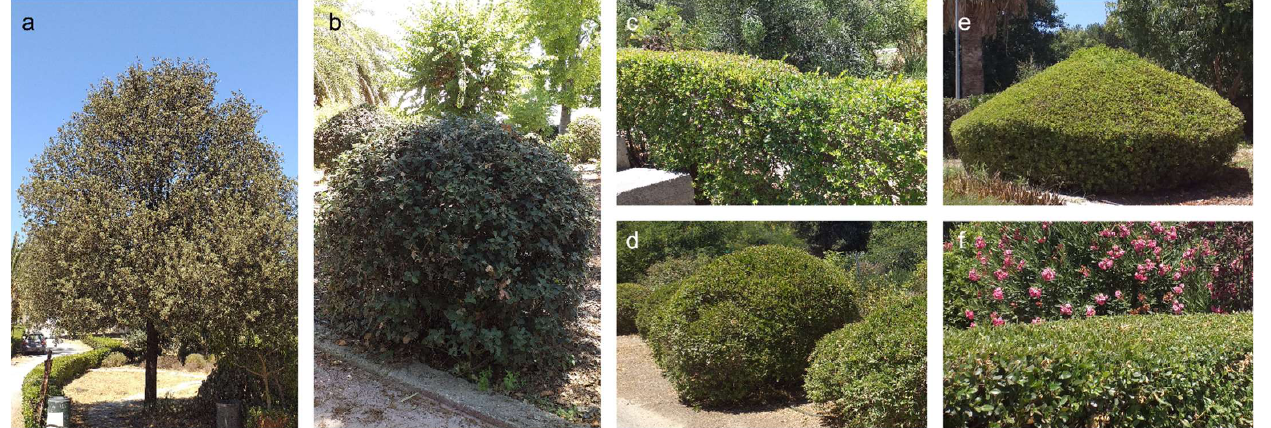
Figure 2. Native Mediterranean plants formed: Querqus ilex L. in (a) free and (b) spherical form. Myrtus communis L. in (c) a hedge and (d) spherical form. (e) Pistacia lentiscus L. as formed plant , (f) and Rhamnus alaternus L. as a hedge. Photos: I. Christoforidi. Table 1. Suggested use and function of native Mediterranean plants in landscape architecture. IP: individual planting; CL: group or cluster planting; PP: pot plant; LΗ: low hedge; HG: hedge; TL: tree line; FB: flower bed; RG: rock garden; TS: tree for shade; GC: ground cover or slope cover.